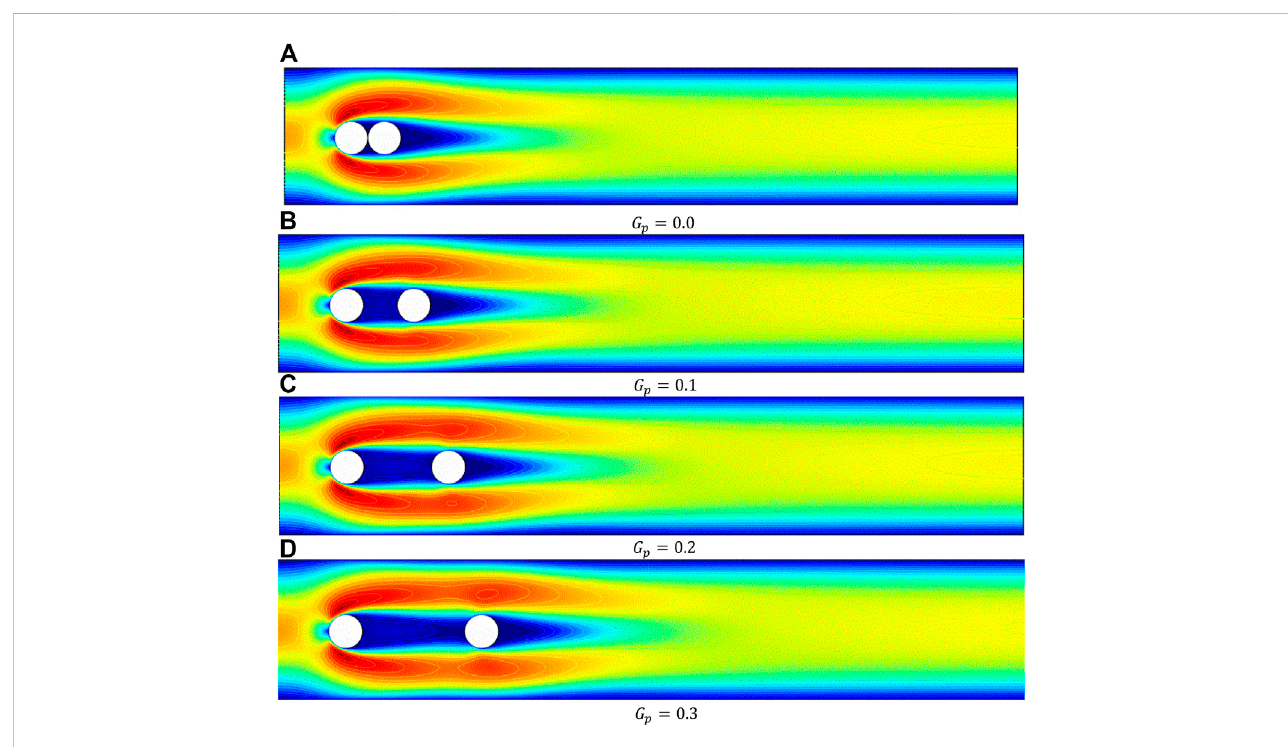
FIGURE 4 In fl uence on velocity for various gap spacings of a cylinder with n (cid:2) 0 . 5 and Re (cid:2) 20.